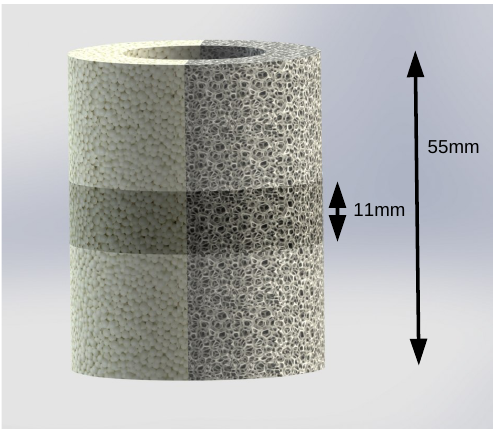
Figure 2. Schematic representation of the catalytic zone in the beads and in the foam